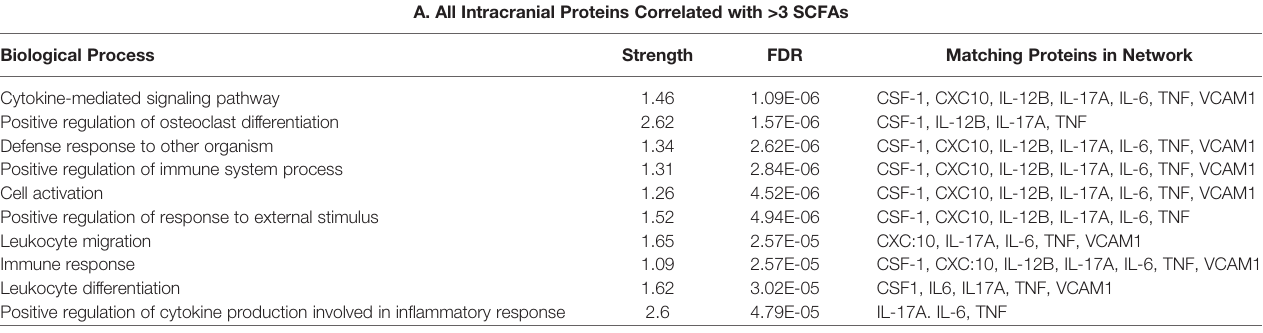
TABLE 4 | Biological processes associated with STRING networks for all intracranial proteins with >3 SCFA correlations (a), intracranial proteins correlated with propionate, isobutyrate, butyrate, and 2-methylbutyrate (b) and all systemic proteins with >3 SCFA correlations (c).